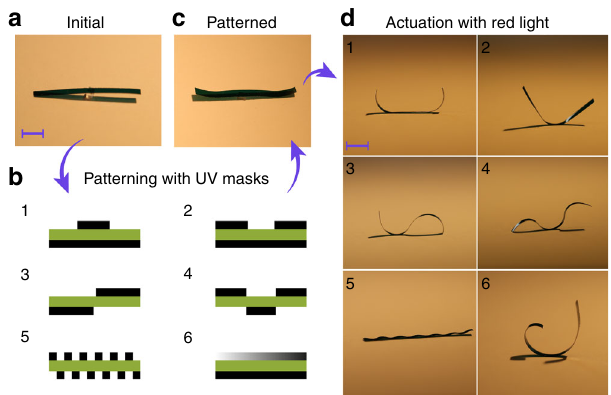
Fig. 4 Recon fi gurable shape morphing. a Optical image of the actuator at the initial stage. b Schematic of mask patterns. c Optical image of the actuator after UV exposure using mask no.1. d Photothermally induced shape morphing upon red-light illumination after different mask